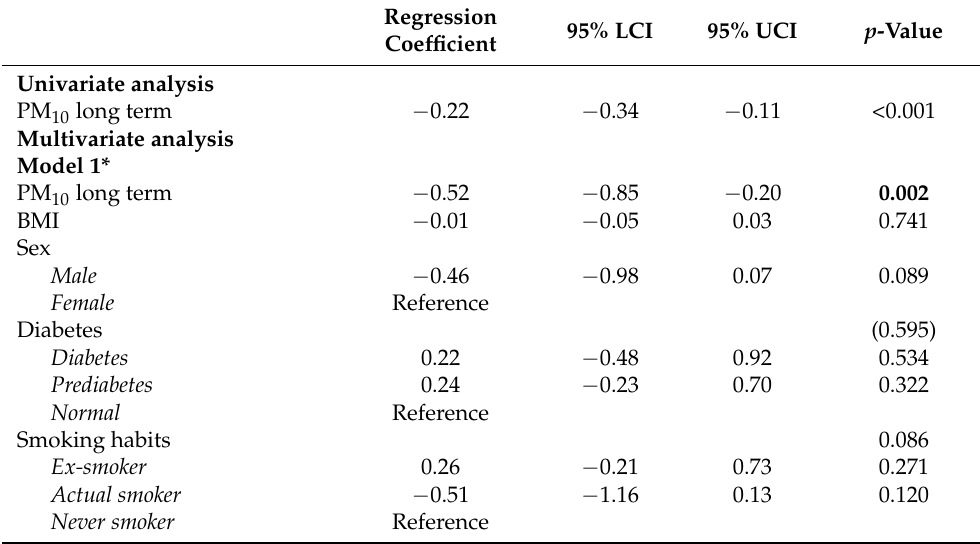
Table 5. Association between PM 10 long term and DNA adducts from univariate and multivariate regression analysis. Statistically significant results are highlighted in bold character in p -Value